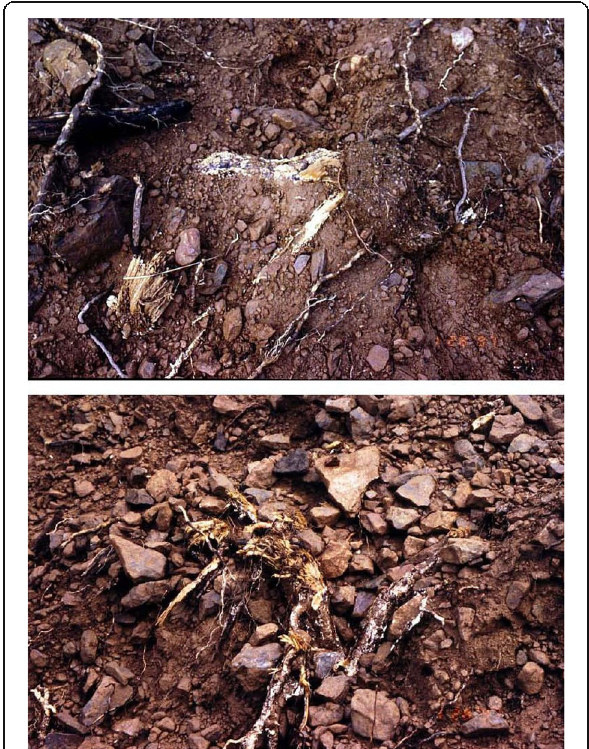
Fig. 4 Two close up views of roots exposed in the east slide plane where the Pilot Ridge debris flow initiated. These brittle, sheared exposed roots were widely spread across both east and west initiation